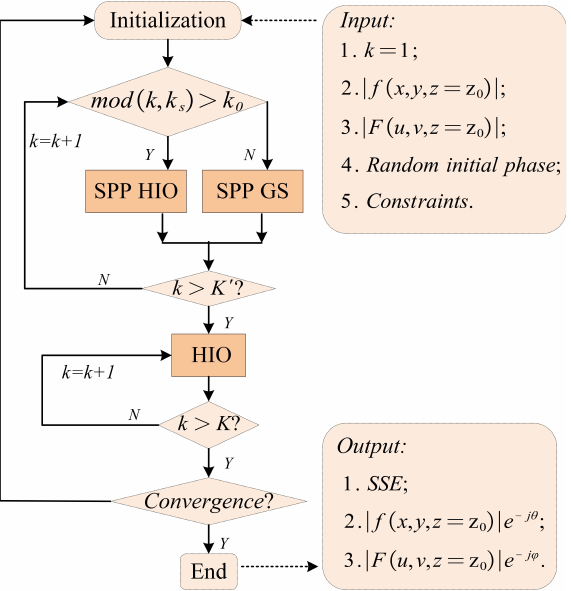
Figure 2. Illustrated process of performing SPP GS/HIO-HIO